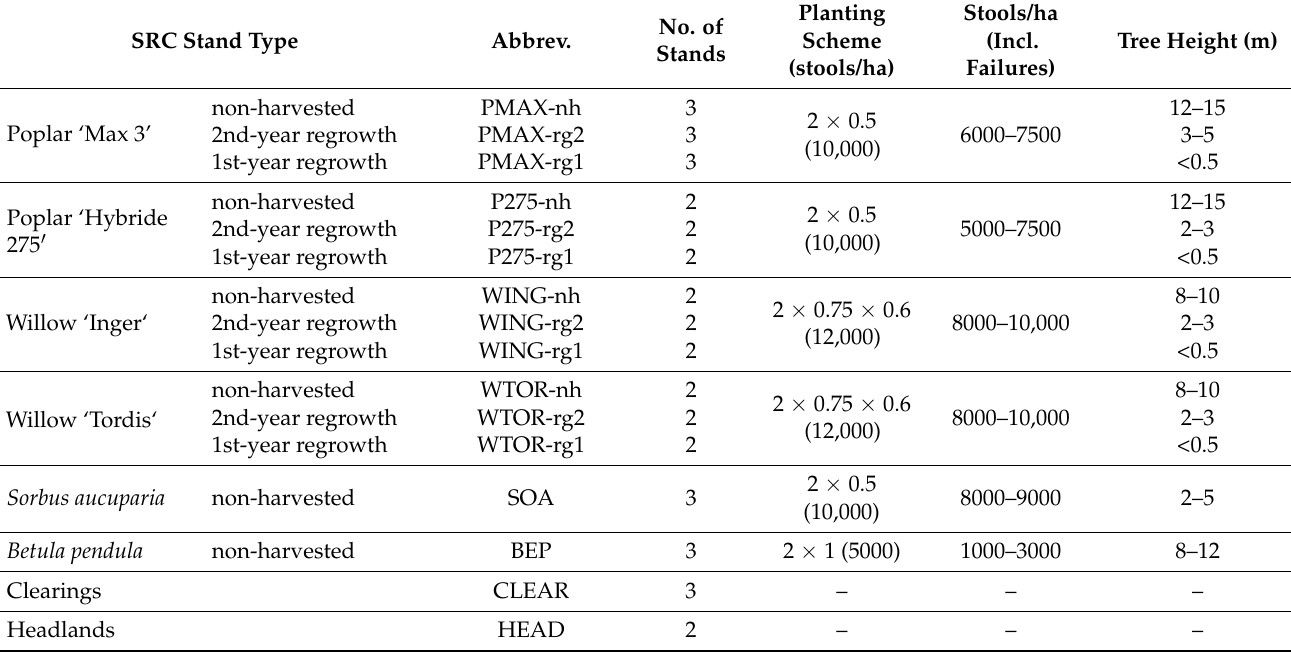
Table 2. Characteristics of the surveyed SRC stand